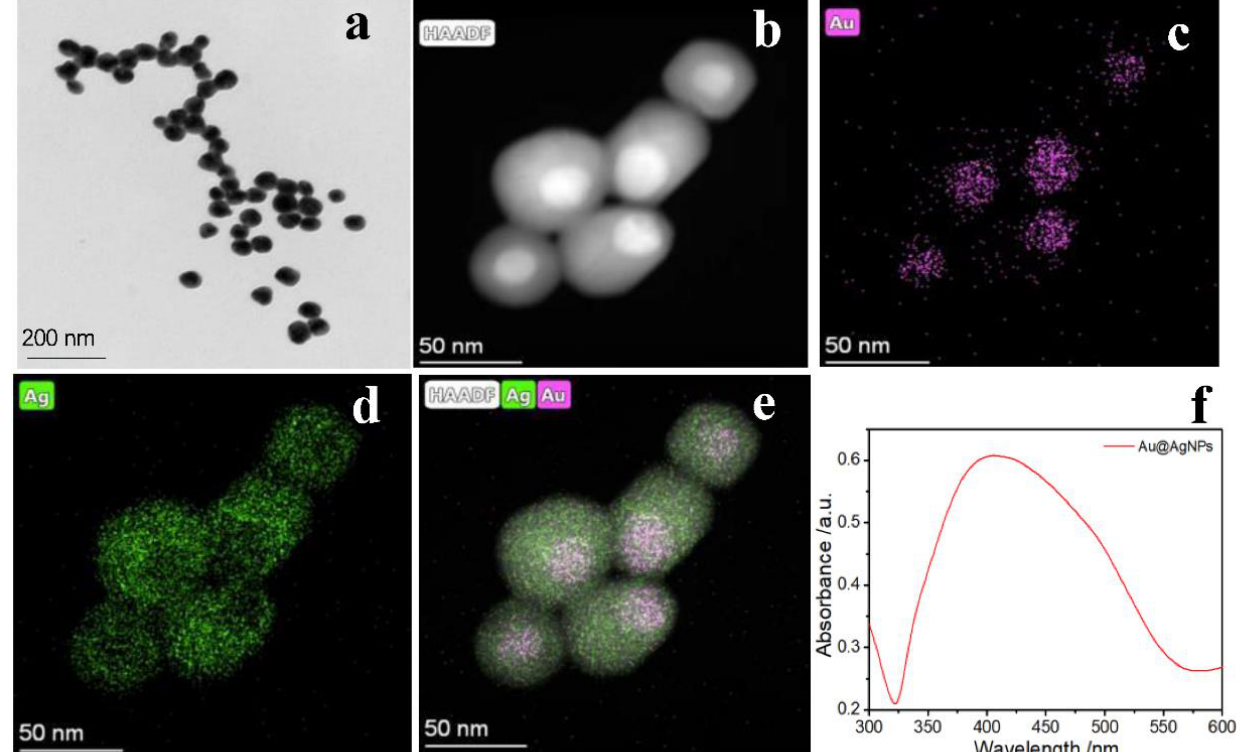
Figure 1. ( a ) The TEM of Au@AgNPs; ( b ) HAADF-STEM image of Au@AgNPs; ( c , d ) the HAADF- STEM-EDX elemental mapping of Au and Ag, respectively; ( e ) the overlay image of the Au and Ag elemental maps; ( f ) the UV–vis absorption spectrum of Au@AgNPs.